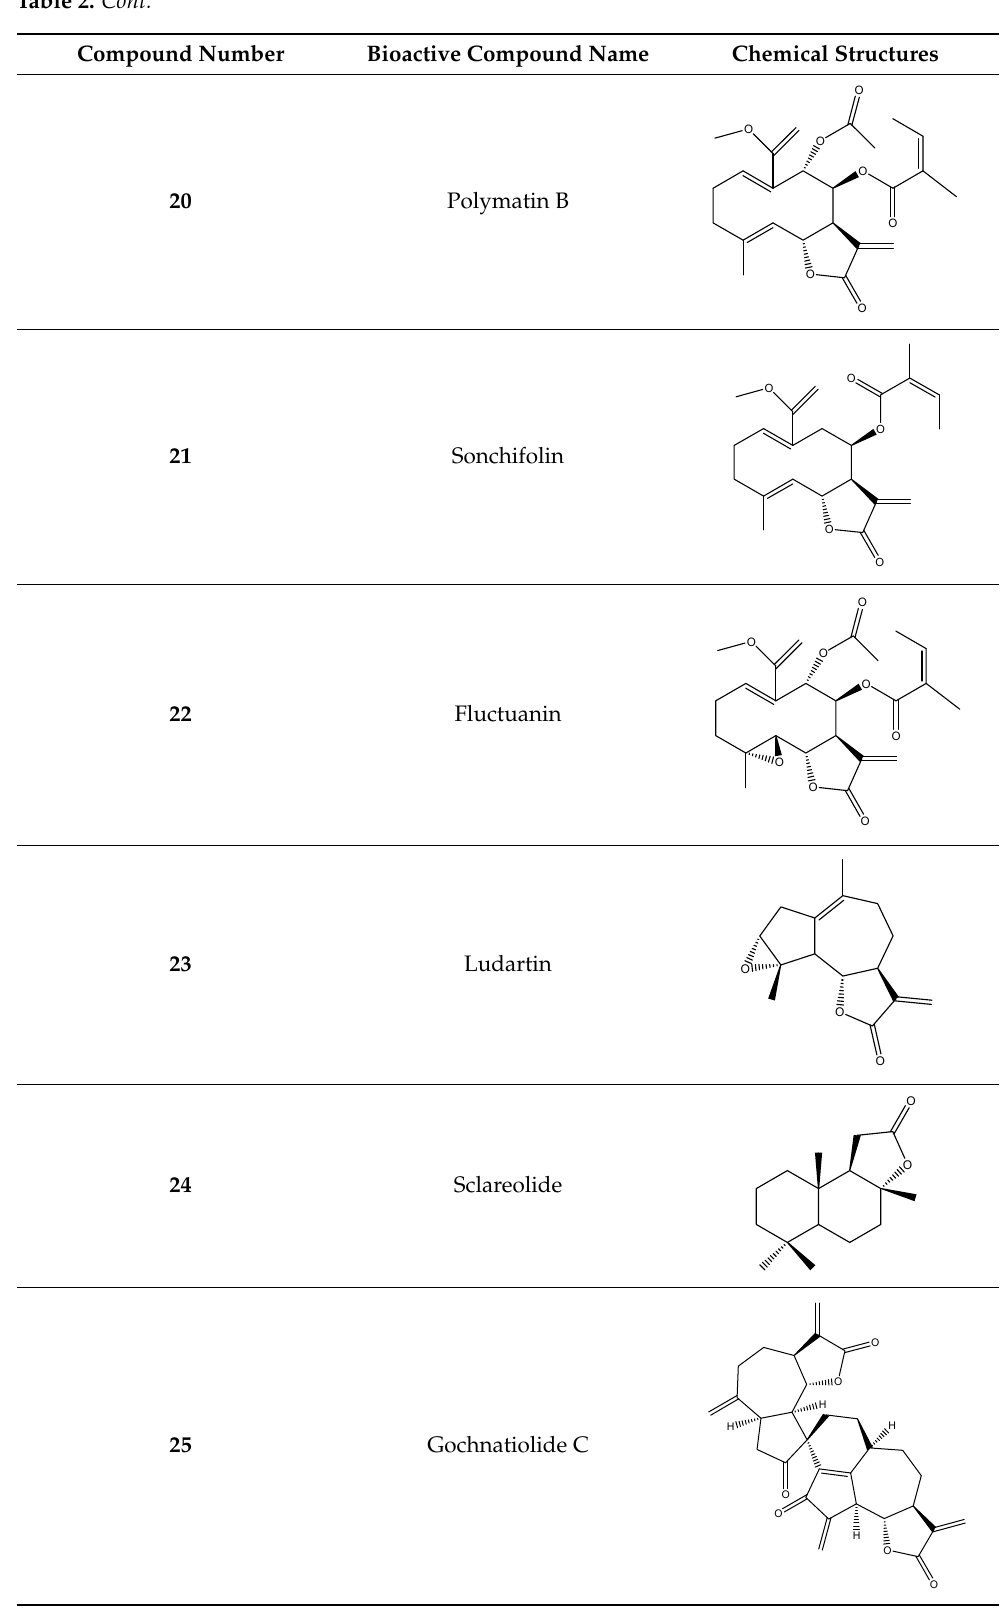
Table 2. Cont. Compound Number Bioactive Compound Name Chemical